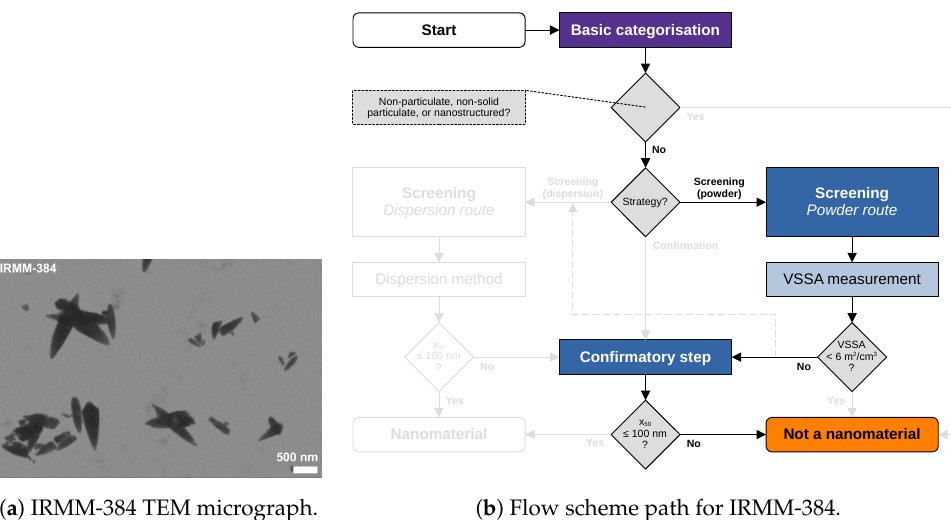
Figure 6. IRMM-384 (CaCO 3 , fine grade): ( a ) representative TEM micrograph, and ( b ) the respective flow scheme path. The tier 1 method BET yielding a VSSA = 15 m 2 /cm 3 does not necessarily lead to a “nanomaterial” categorisation in a subsequent confirmatory step. The following tier 2 method TEM yielding an x 50 = 153 nm leads to a “not a nanomaterial”